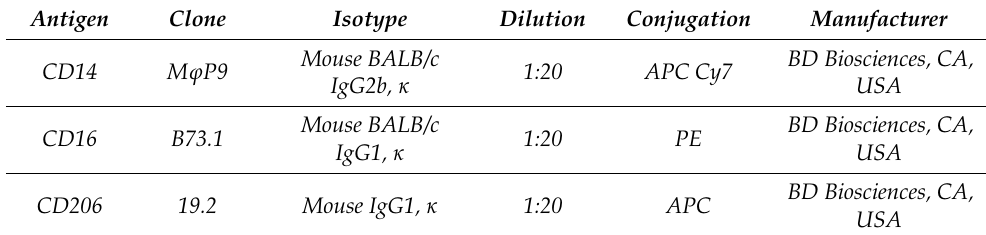
Table 1. List of antibodies used for flow cytometry